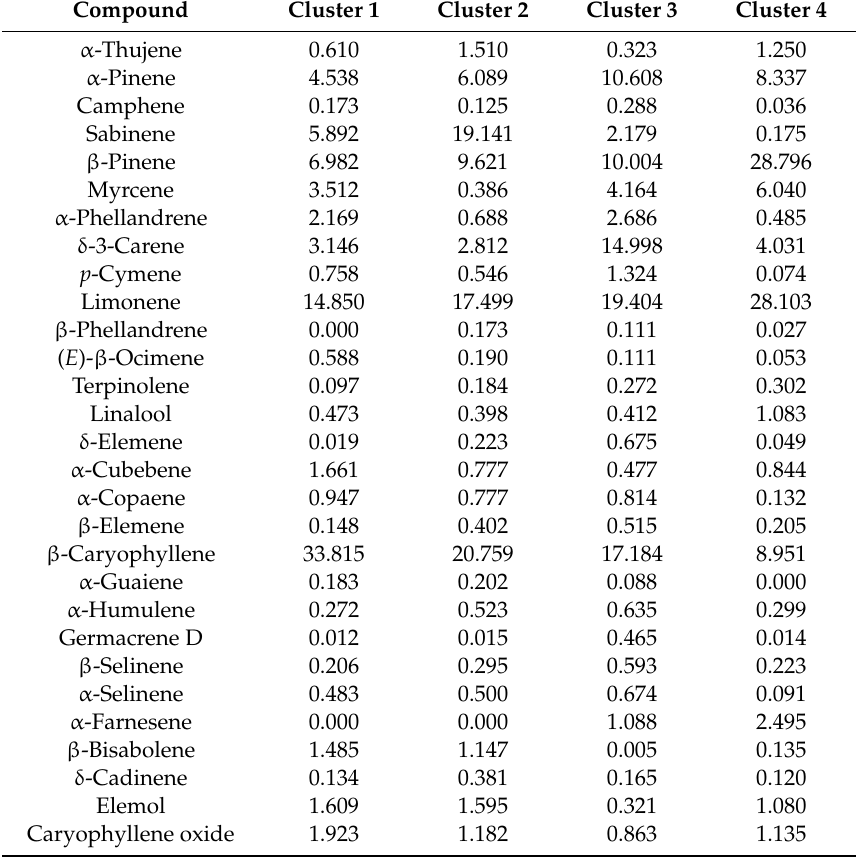
Table 4. Concentration (%) of centroids used in the cluster analysis of Piper nigrum